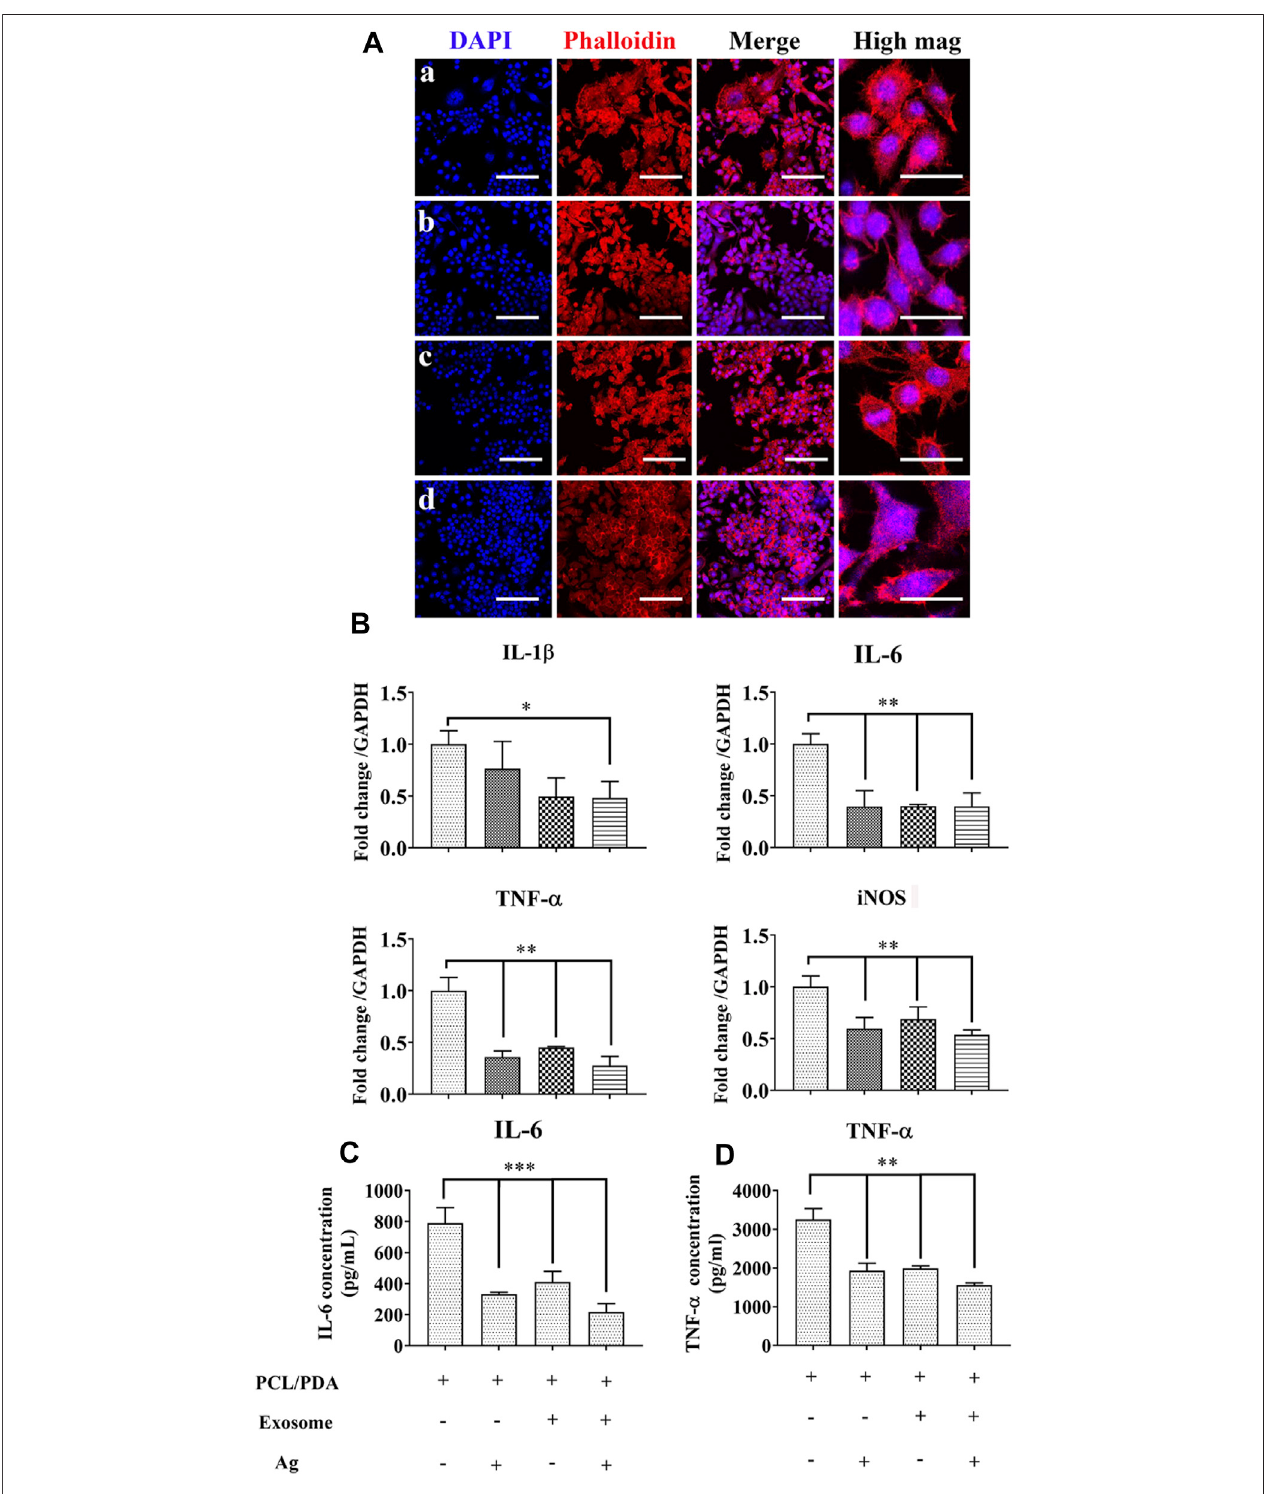
FIGURE 4 | Effect of the exosome and Ag hybrid scaffold on in fl ammatory macrophages. (A) Representative confocal microscopy images of RAW264.7 cells cocultured with the exosome and Ag hybrid scaffold. In fl ammatory macrophages were induced by 1000 ng/ml LPS stimulation for 12 h. After washing, in fl ammatory macrophages were cocultured with the MSC-exosome and Ag hybrid scaffold. Cells were stained by Alexa Fluor 594-conjugated phalloidin and DAPI. (a – d) refer to LPS+PCL/PDA, LPS+PCL/PDA/Ag, LPS+PCL/PDA/exosome, and Ag/exosome hybrid, respectively. Scale bars (cid:2) 100 μ m. Scale bars (cid:2) 20 μ m (high mag). (B)